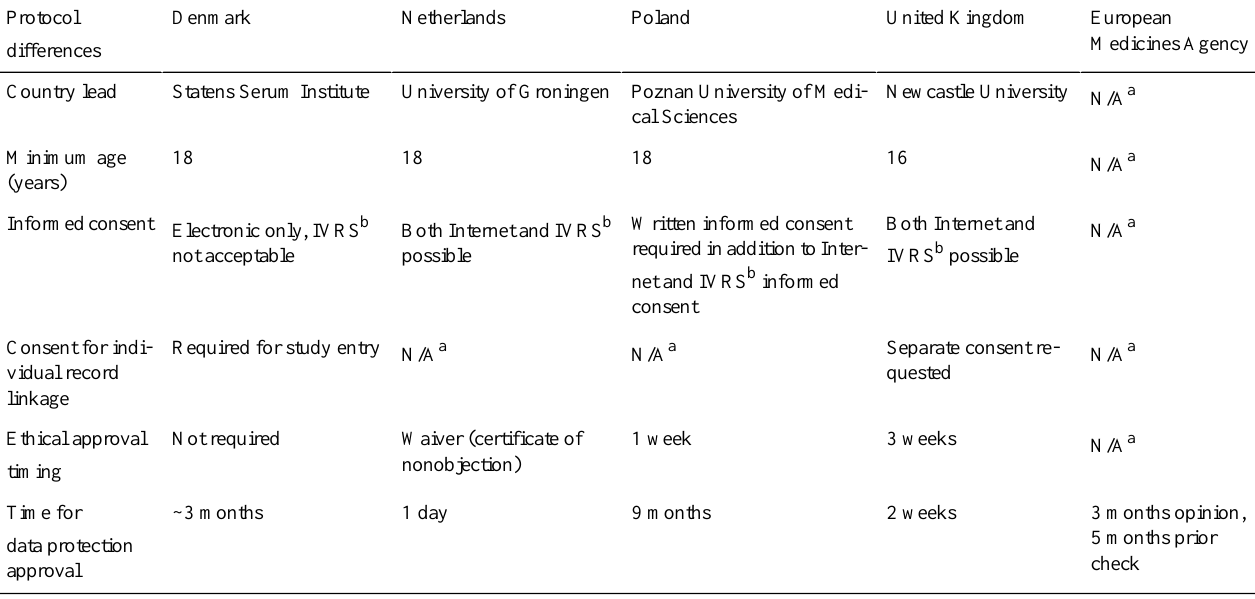
Table 1. Country specific protocol differences; ethical and data protection requirements and